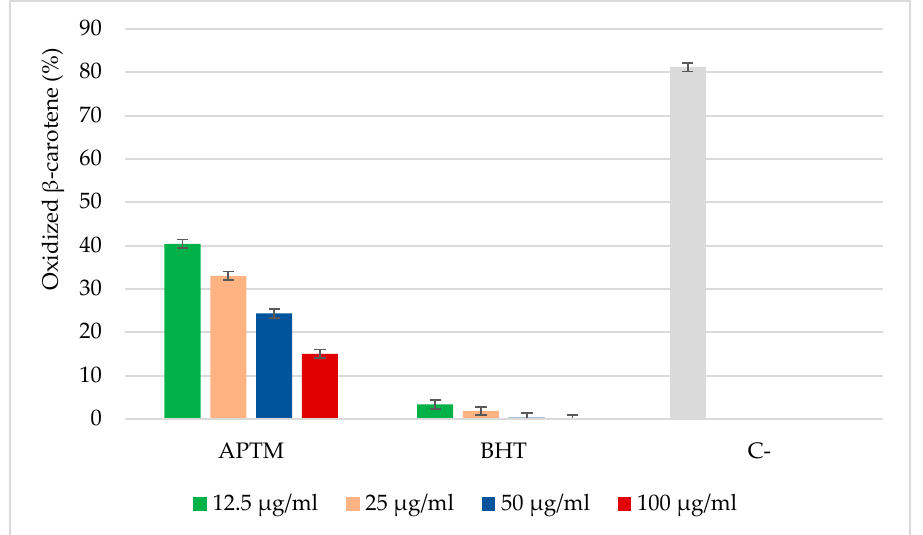
Figure 2. Effect of aqueous extract of APTM against β -carotene oxidation, C - : negative control; BHT: butylated hydroxytoluene. Table 1. Signs of acute toxicity of the aqueous extract of